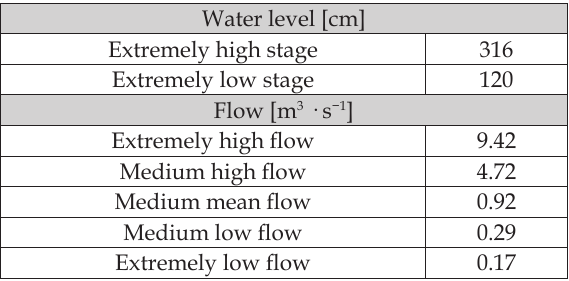
Table 4. Characteristic water level and flow of the Moszczenica River measured in the gauging station in Gieczno in 1971–1990 (after Szczepański